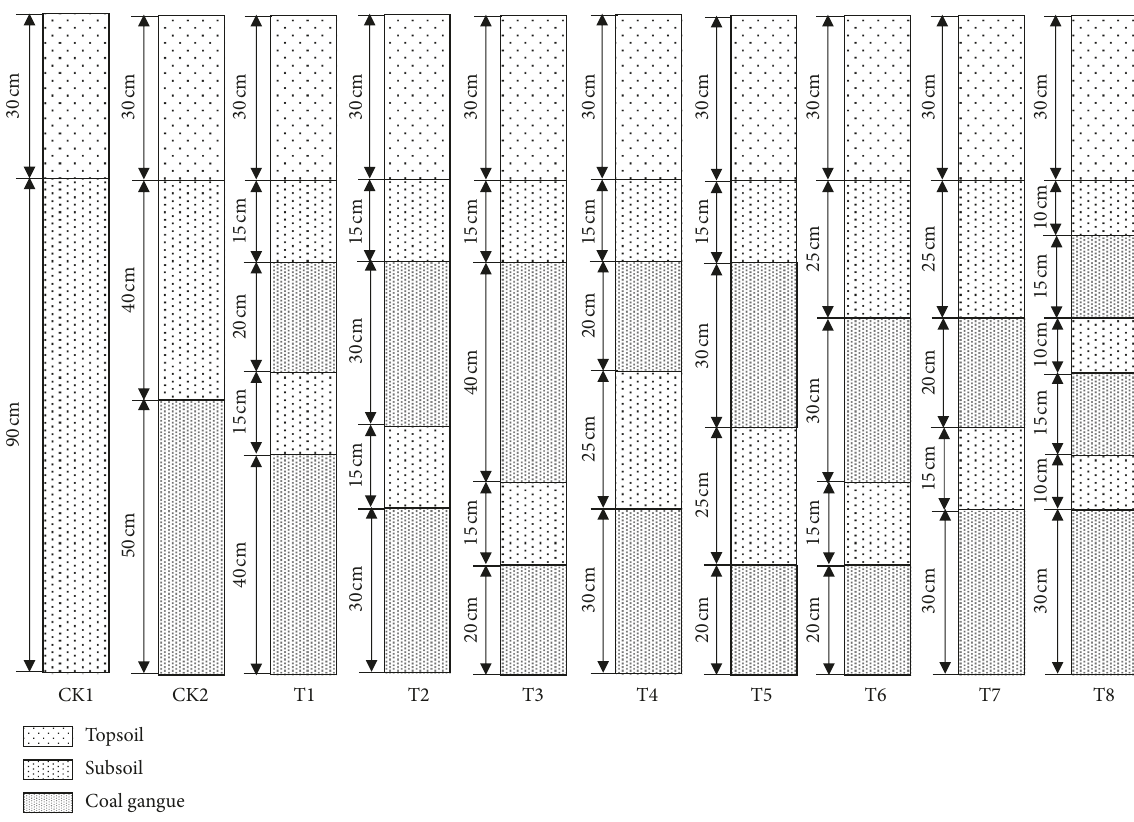
Figure 2: Diagram of different multilayered soil-gangue profiles for reclaiming subsided land with gangue.